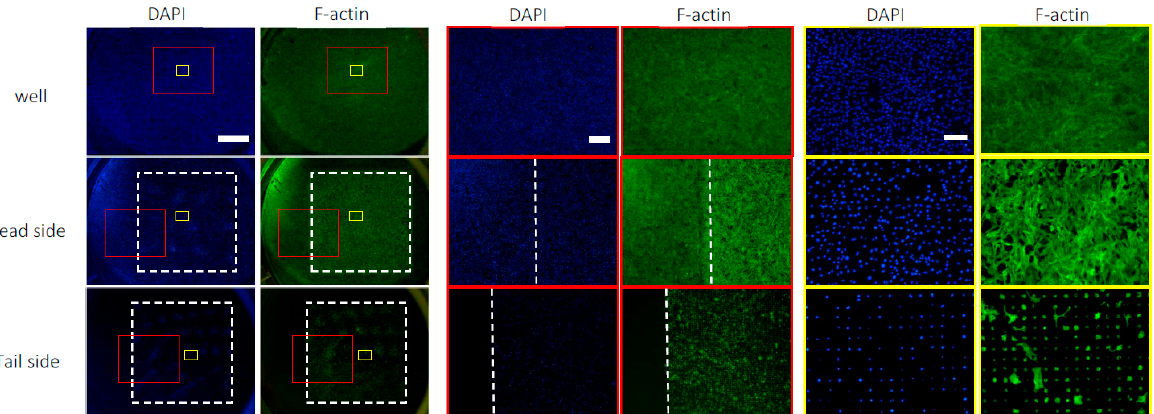
Figure 5. The fluorescence images of C3H10T1/2 cells cultured for 24 h on the head side and in the blank well. F ‐ actin was detected by immunostaining (green) and nuclei were visualized by staining with DAPI (blue). The top row shows images on the head side, and the bottom row shows those on the tail side. The images are shown at 3 magnifications (the scale bars represent 150, 750, or 3000 µ m). The microperforated areas are inside the white box in low magnification images, the right side of the white line in middle magnification images, and in the entire area in high magnification